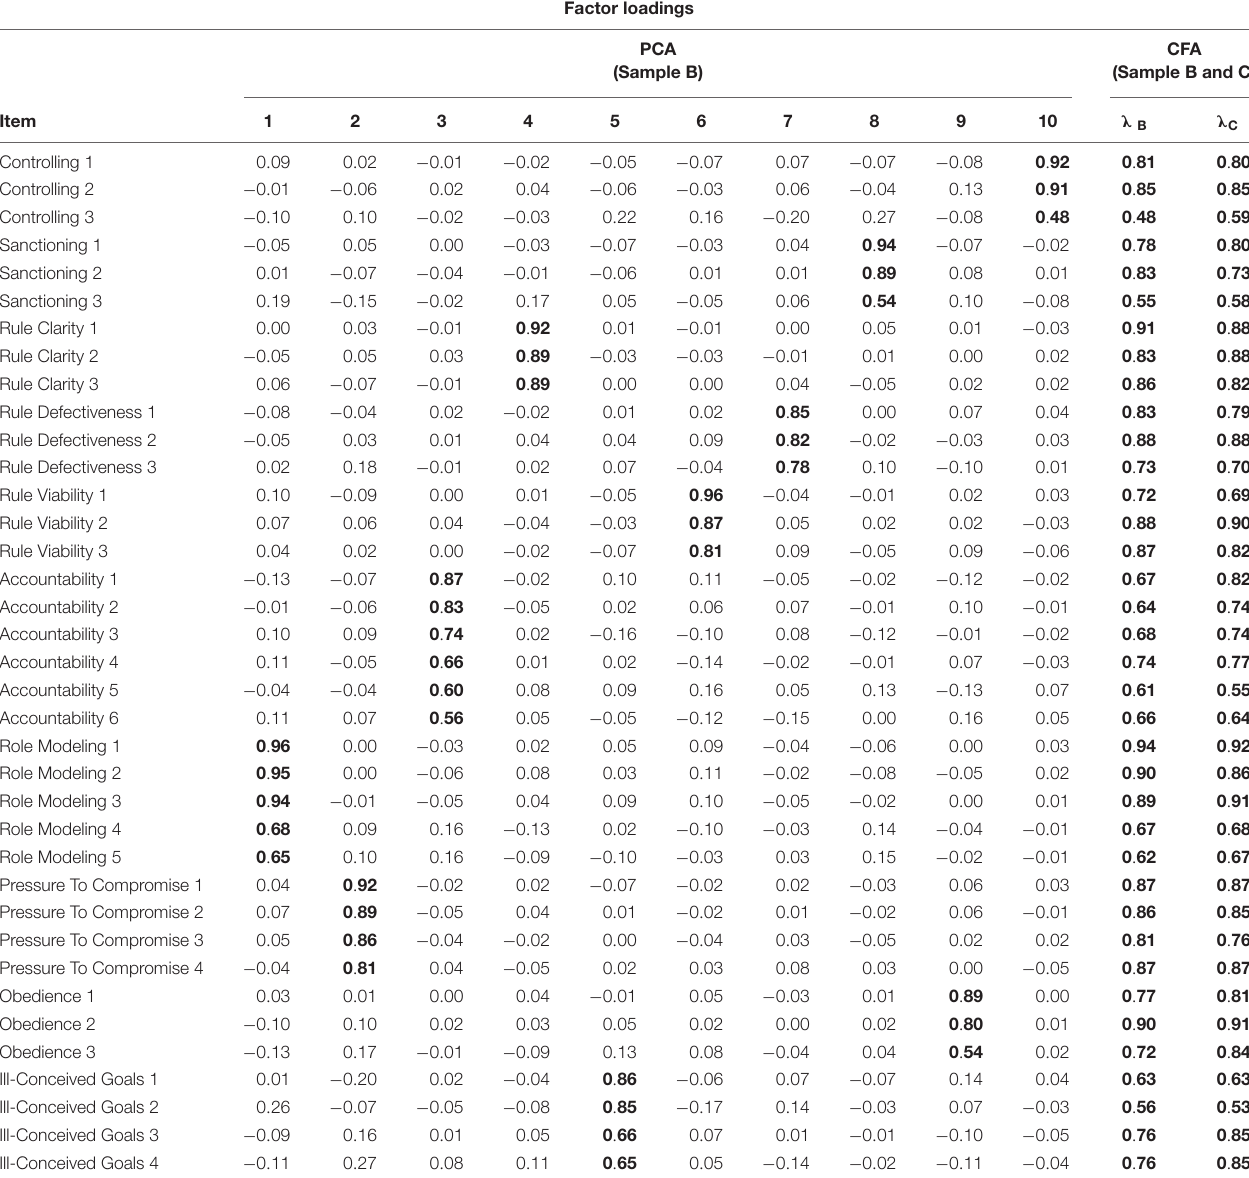
TABLE 2 | EFA factor loadings and CFA standardized factor loadings (Study